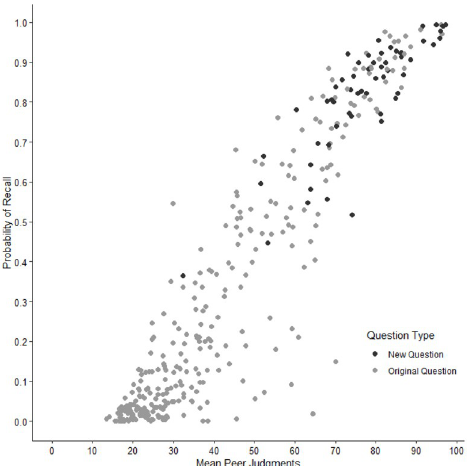
Fig 5. Association between probability of recall and mean peer judgments per question. Each dot represents one question. Higher mean peer judgments per question were associated with higher probability of recall.